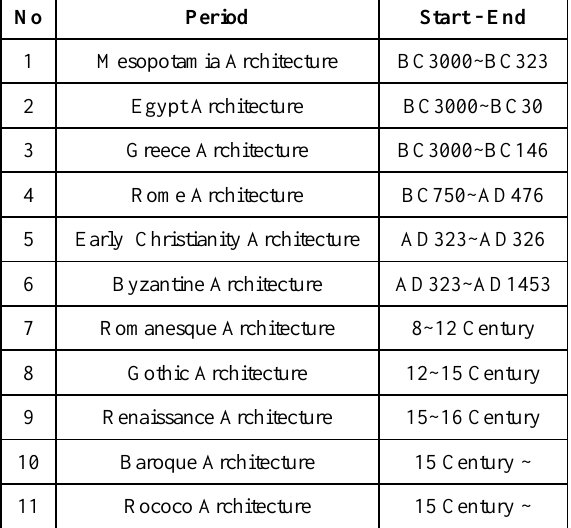
Table 1. Western Architecture progress period